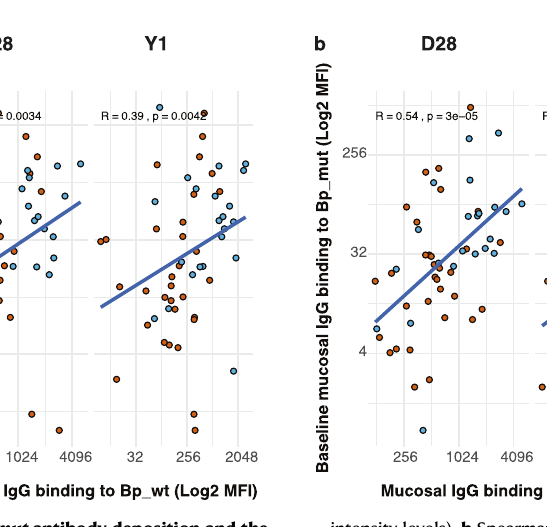
intensity levels). b Spearman correlation between mucosal IgG binding to Bp_mut and mucosal IgG binding to Bp_wt at day 28 and one year (log2-transformed mean fl uorenscenceintensitylevels).Forboth a and b ,atwo-sided spearmancorrelation was performed and the correlation factor R and p -value are depicted in the fi